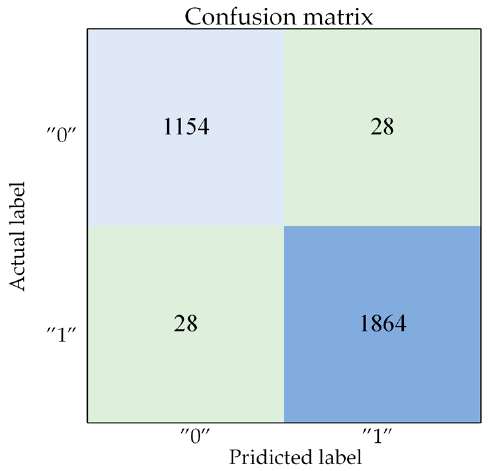
Figure 6. Confusion matrix of classification with adjustable and non-adjustable air velocity.